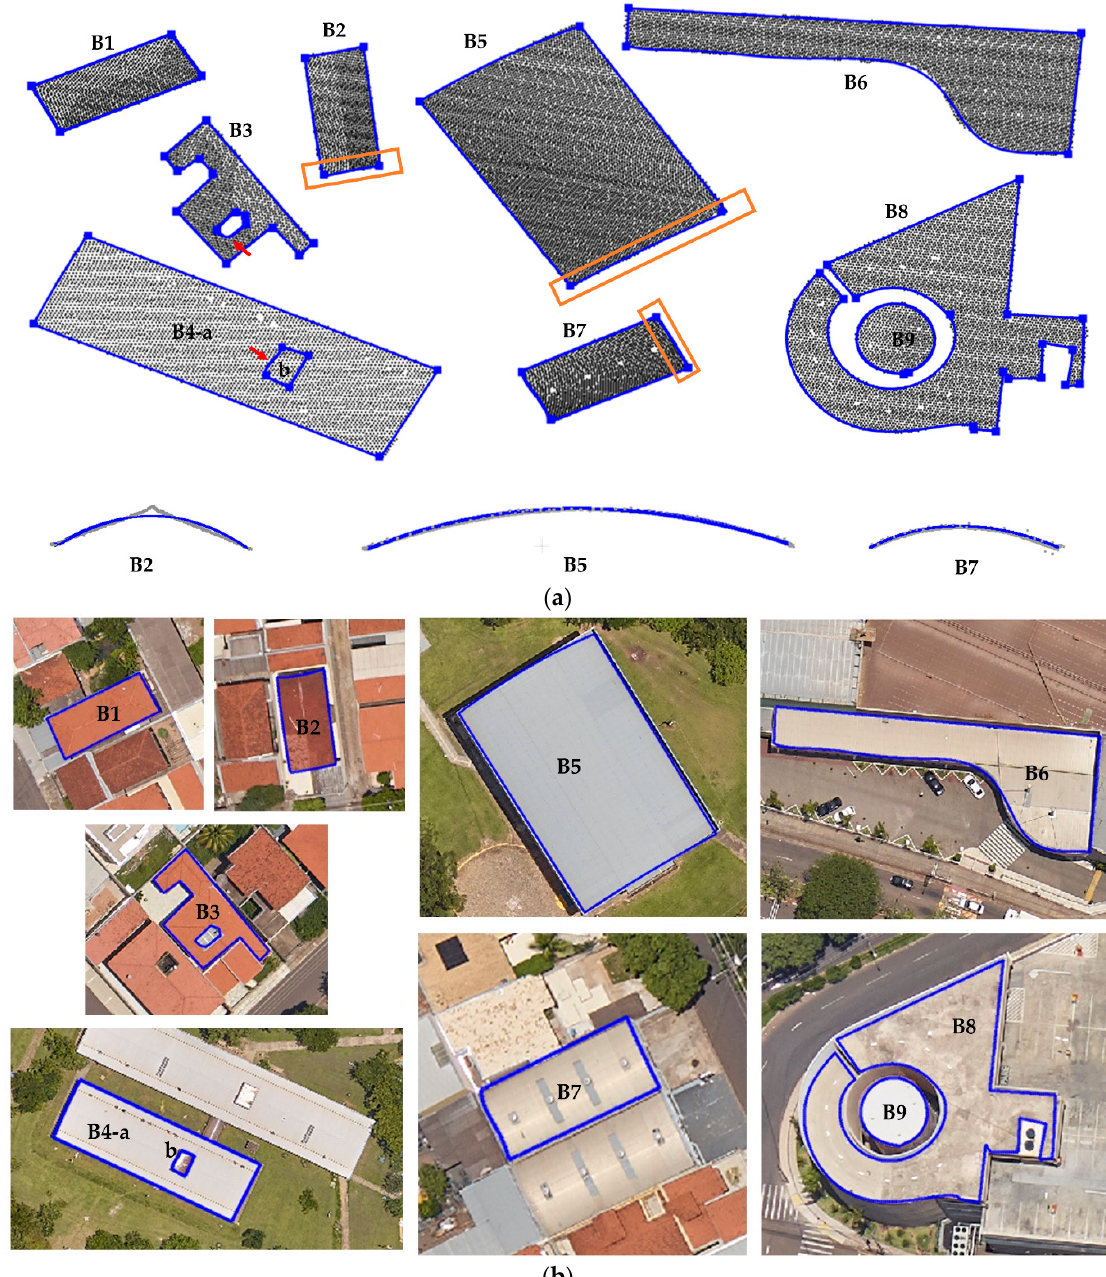
Figure 11. Presidente Prudente / Brazil dataset. Building boundary regularization results derived from the proposed strategy using a point cloud with 12.5 points / m 2 . Boundaries and corner points (square blue) over roof points ( a ), and building boundaries projected onto the aerial image ( b ).